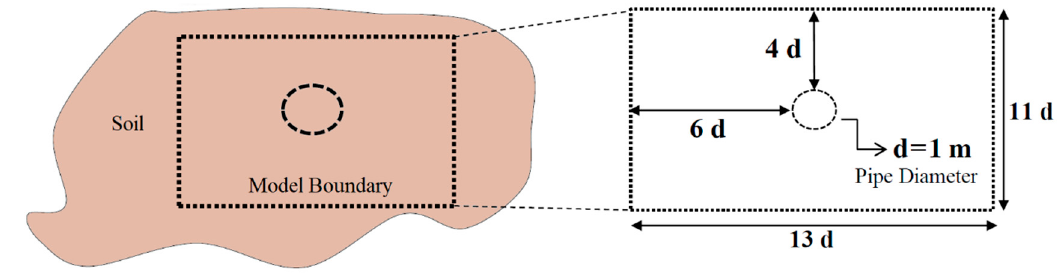
Figure 4. Cross section of the pipe and soil.